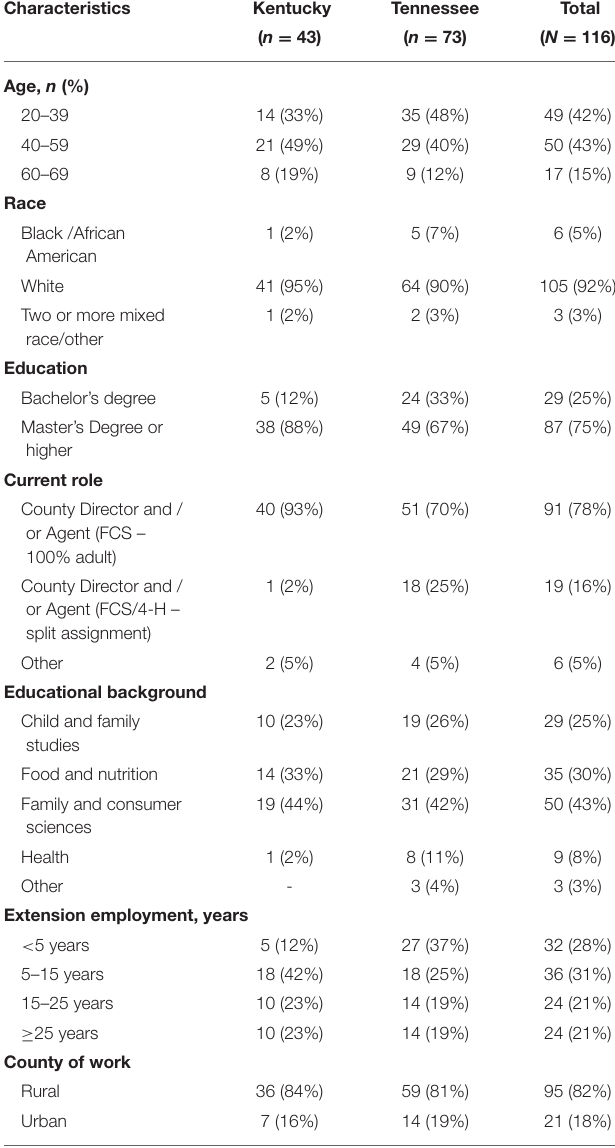
TABLE 2 | Participant demographic characteristics ( n =